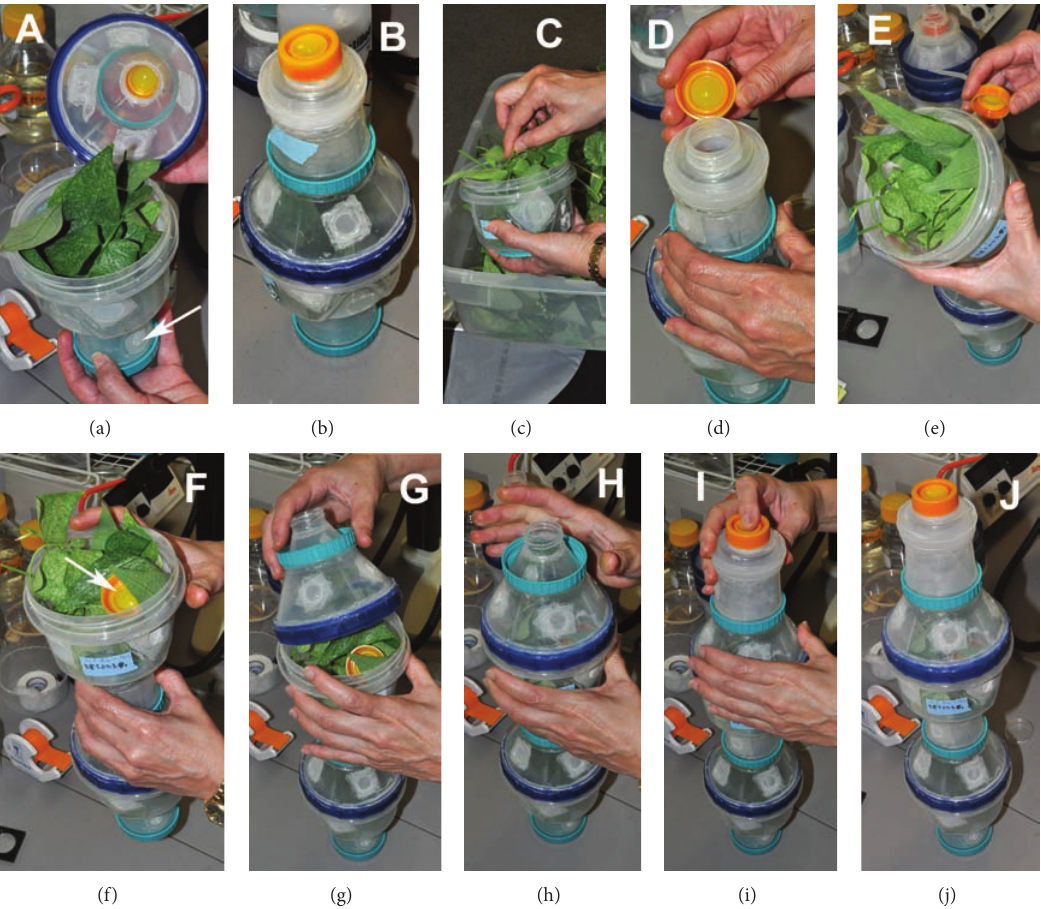
Figure 4: Cage system operation. (a) A cage series starts with a connection cup with predators connected to a cage bottom filed with spider mite-infested bean leaves. (b) The starting cage unit is closed and a connection cup is fitted. (c) When spider mites have been depleted by the predators, a new cage unit is prepared. (d) The cover of the connection cup is removed to allow predators to move to the new cage. (e) A new cage bottom is fitted to the connection cup. (f) The connection cup cover is placed inside the new cage. (g) The new cage is covered and (h) sealed, and (i) a new connection cup is fitted to the cover. (j) The process can be repeated by adding a third cage unit when prey has been depleted. At this point, the bottom connection cup can be replaced by the stand